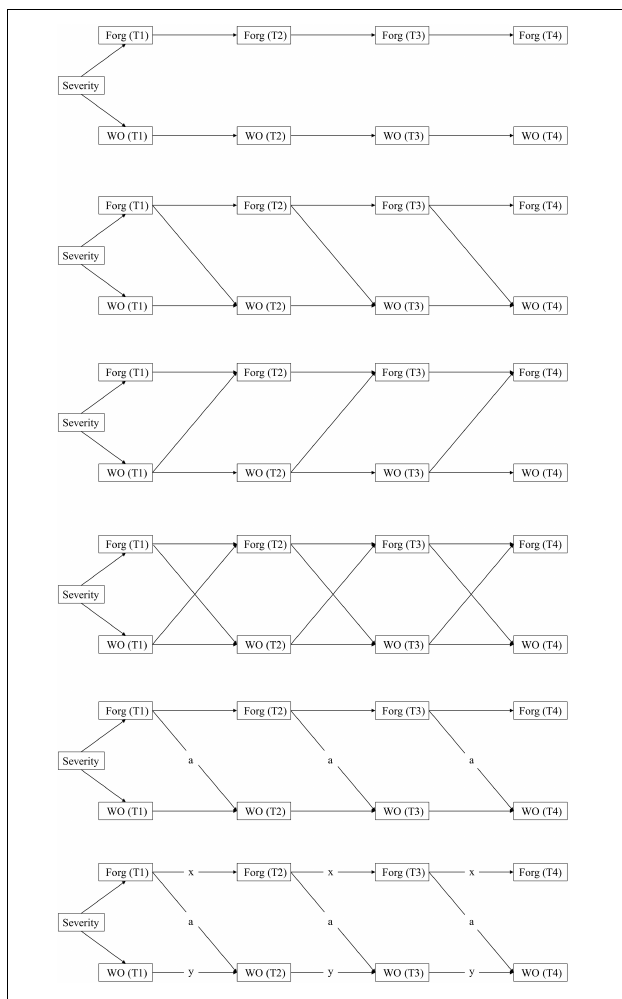
FIGURE 1 | Schematic representation of competing models. Forg = Forgiveness; WO = Work outcomes; T1–T4 refer to Time 1-Time 4, respectively. Paths labeled “x” and “y” estimate stability coefficients. Paths labeled “a” and “b” estimate cross-lagged coefficients.